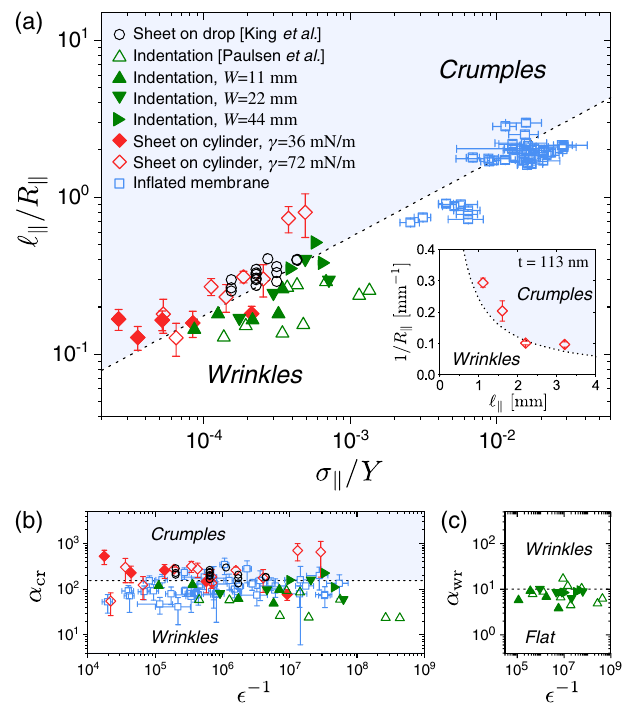
FIG. 5. Phase diagram for wrinkles and crumples. (a) Crum- pling threshold measured in the four experimental setups in Fig. 1, including sheet-on-droplet data from King et al. [25] and indentation data from Paulsen et al. [20]. Values of l k , R k , and σ k are either measured or deduced from other measured quantities (see Table I). The sheet thickness ranges from 40 < t < 630 nm for the polymer films and 15 < t < 222 μ m for the inflated membranes. Indentation data have γ ¼ 72 mN = m and W shown in the legend. Sheet-on-cylinder data have W ¼ 3 . 2 mm and γ shown in the legend. Parameters for inflated membranes are detailed in Fig. 6(a) and 6(b). The data are reasonably well ¼ 155 (dashed line). Inset: described by Eq. (2) with α ¼ α cr Threshold curvature 1 =R k for crumpling, versus wrinkle length γ . Dashed line: l k , in the sheet-on-cylinder setup at fixed t and Equation (2) with α ¼ 155 . (b) Crumpling threshold versus bendability ϵ − 1 . The threshold is approximately constant over a wide range of bendability. (c) Wrinkling threshold in the indentation setup, measured in the same indentation experiments as (a),(b). The scatter in the filled and open triangles is similar in magnitude to their scatter in (b),